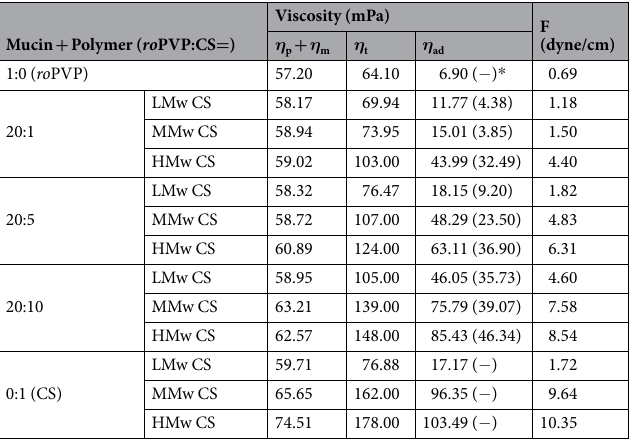
Table 1. Viscosity of a 9.38% (w/v) mucin solution ( η m ) plus 0.50% (w/v) polymer solution ( η p + η m ), of the system ( η t ), and viscosity due to mucoadhesion ( η ad ) as well as the force of mucoadhesion ( F ) of blends of different molecular weights (Mws) of chitosan (CS), ring-opened polyvinyl pyrrolidone ( ro PVP), and ro PVP/ chitosan (CS) at various ratios at 25 °C using a shear rate of 10 per second. * Values in parentheses indicate a synergetic effect of viscosity and mucoadhesion. LMw, low molecular weight; MMw, medium molecular weight; HMw, high molecular